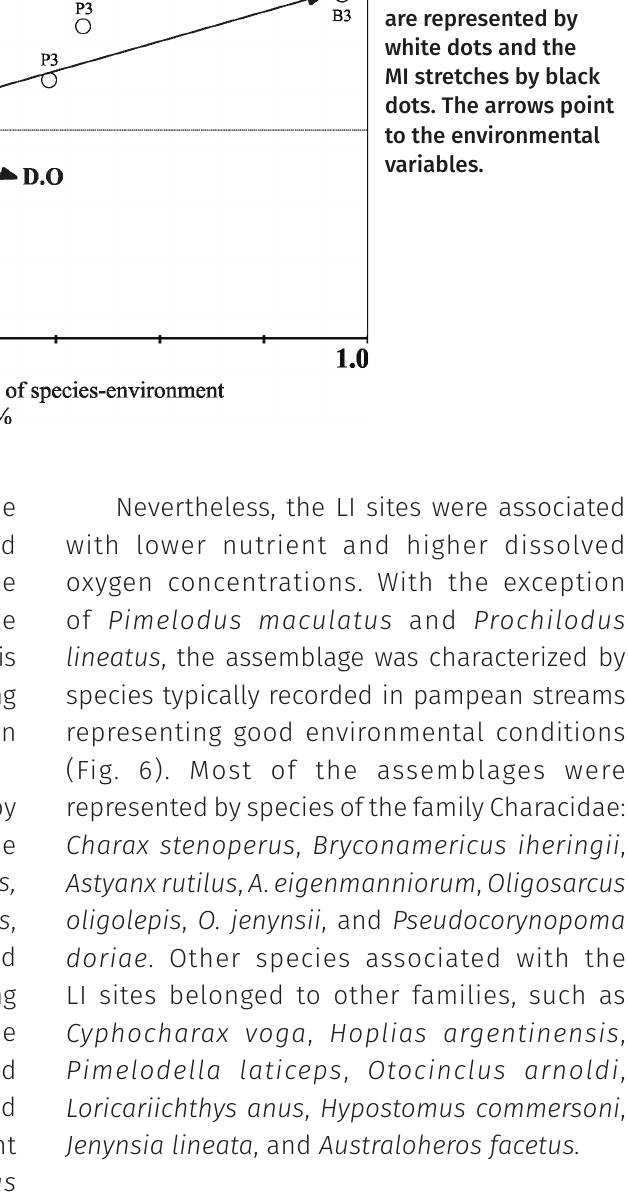
The LI stretches are represented by white dots and the MI stretches by black dots. The arrows point to the environmental